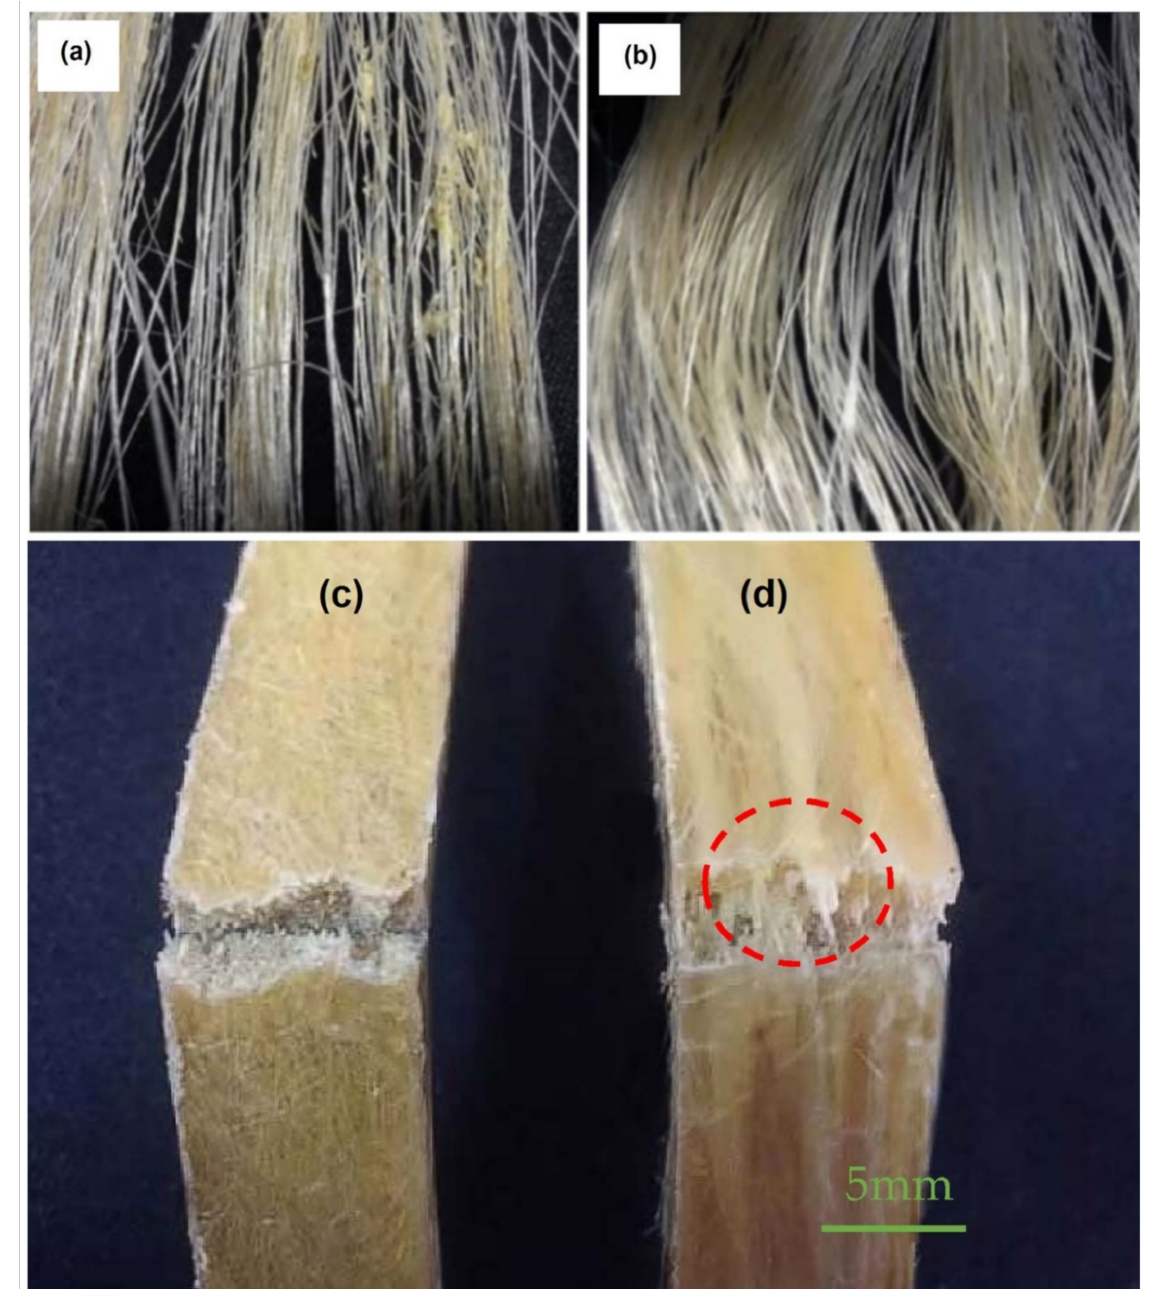
Figure 13. Sisal fibers ( a ) before alkali treatment, ( b ) after alkali treatment, ( c ) flexural strength test for short sisal fibers reinforced composites and ( d ) flexural strength test for long sisal fibers reinforced composites. Reprinted with permission from Ref. [125]. Copyright 2021, with permission from